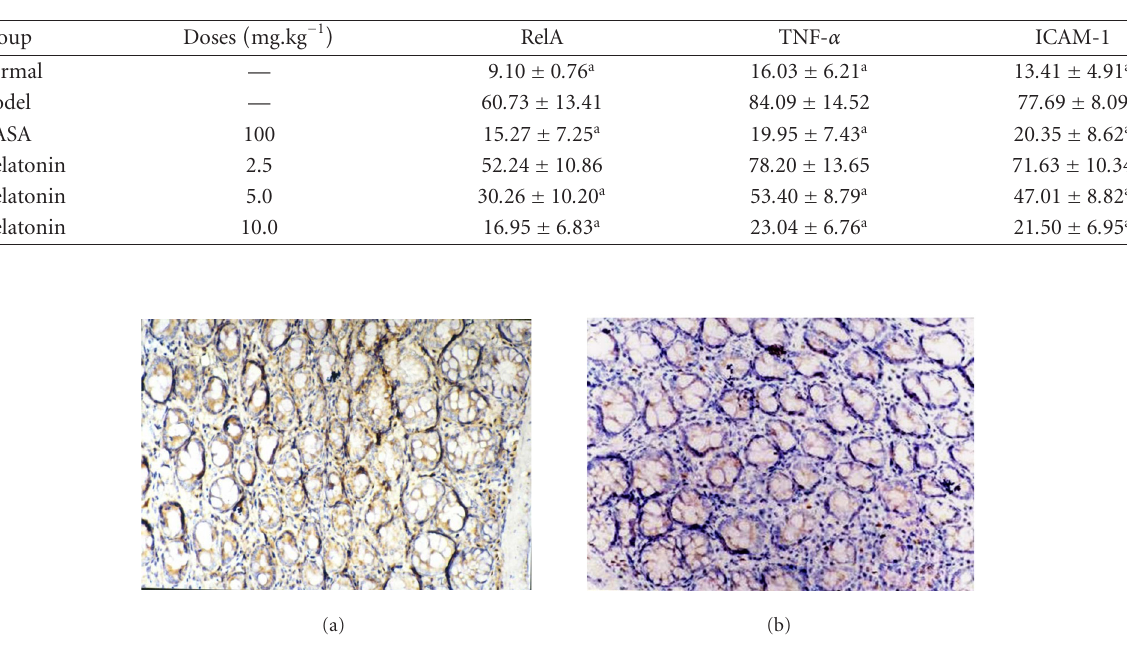
Figure 2. Immunohistochemical staining for TNF- α protein expression in (a) the model group and (b) melatonin group (10mg.kg − 1 ). SP × 200. The number of TNF- α immunoreactive positive cells in melatonin group is significantly less than that of model group.